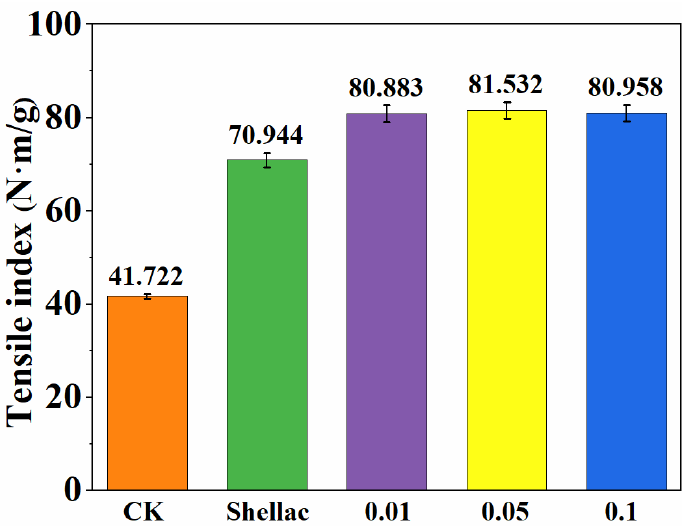
Figure 4. Tensile index of composite paper . Molar ratio of AgNO 3 : NaBH 4 = 1:4, AgNO 3 concentra- tions was 0.01, 0.05 and 0.1 mol/L.